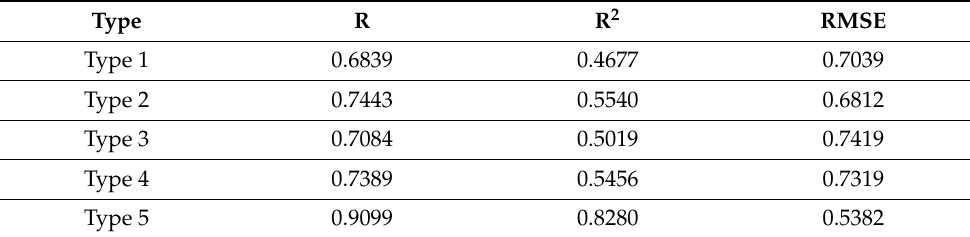
Table 8. Regression analysis results of equations for predicting the axial strain corresponding to the peak compressive strength of the SMA-confined concrete cylindrical specimens.